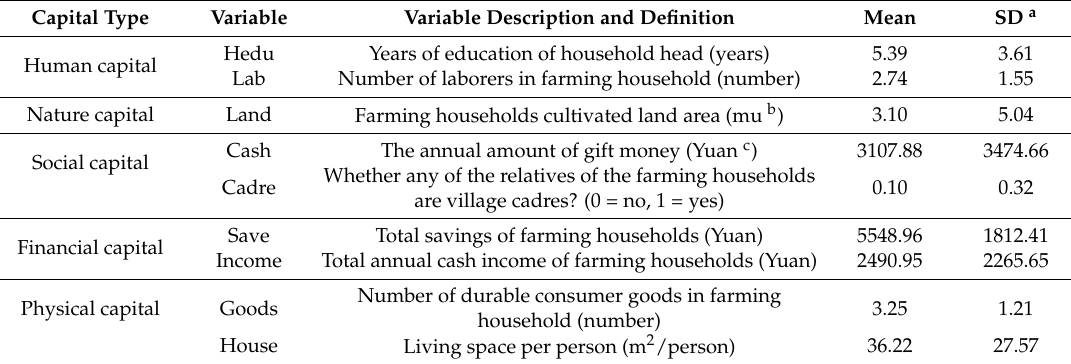
Table 2. The measurement index system for measuring livelihood capital of farming